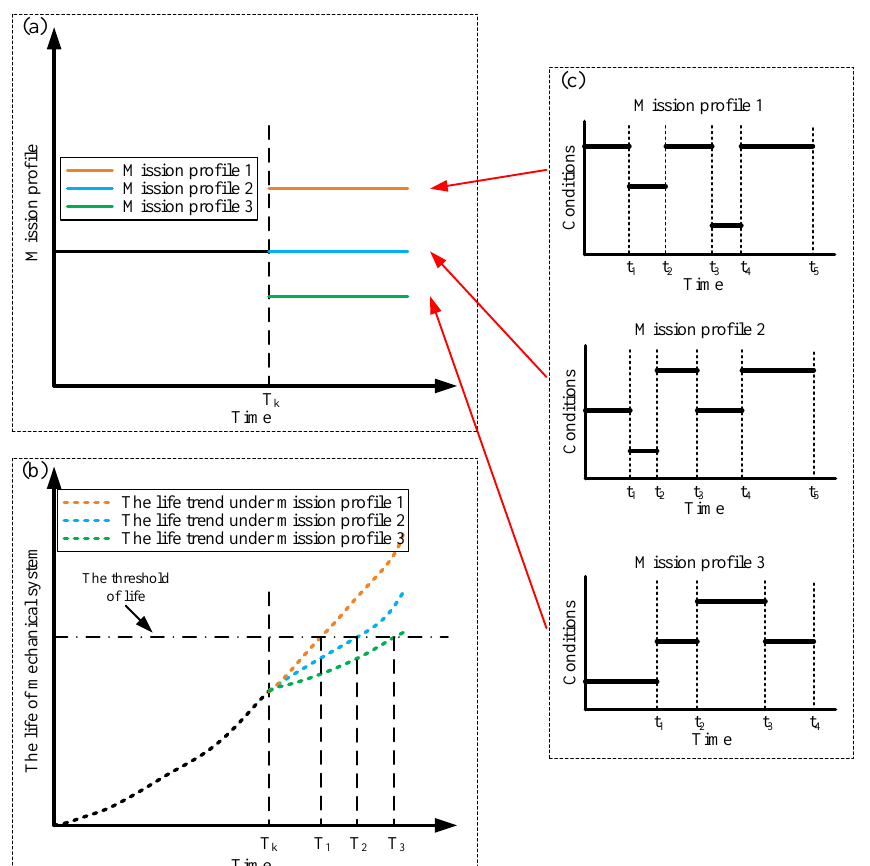
Figure 1. The relationship among operating condition, mission profile, and lifecycle. ( a ) The mission profile experienced by the mechanical system. ( b ) The life trend of the mechanical system under different mission profiles. ( c ) The composition of the mission profile. The mission profile is constituted by operating condition in a certain order as shown in ( c – a ). The life trend and lifecycle are affected by the mission profile as shown in ( a , b ). T k is the switch point of mission profile. T 1 , T 2 , and T 3 is the lifecycle under the mission profiles 1, 2, and 3, respectively. t 1 , t 2 , t 3 , t 4 , and t 5 is the switch point of different operating condition.